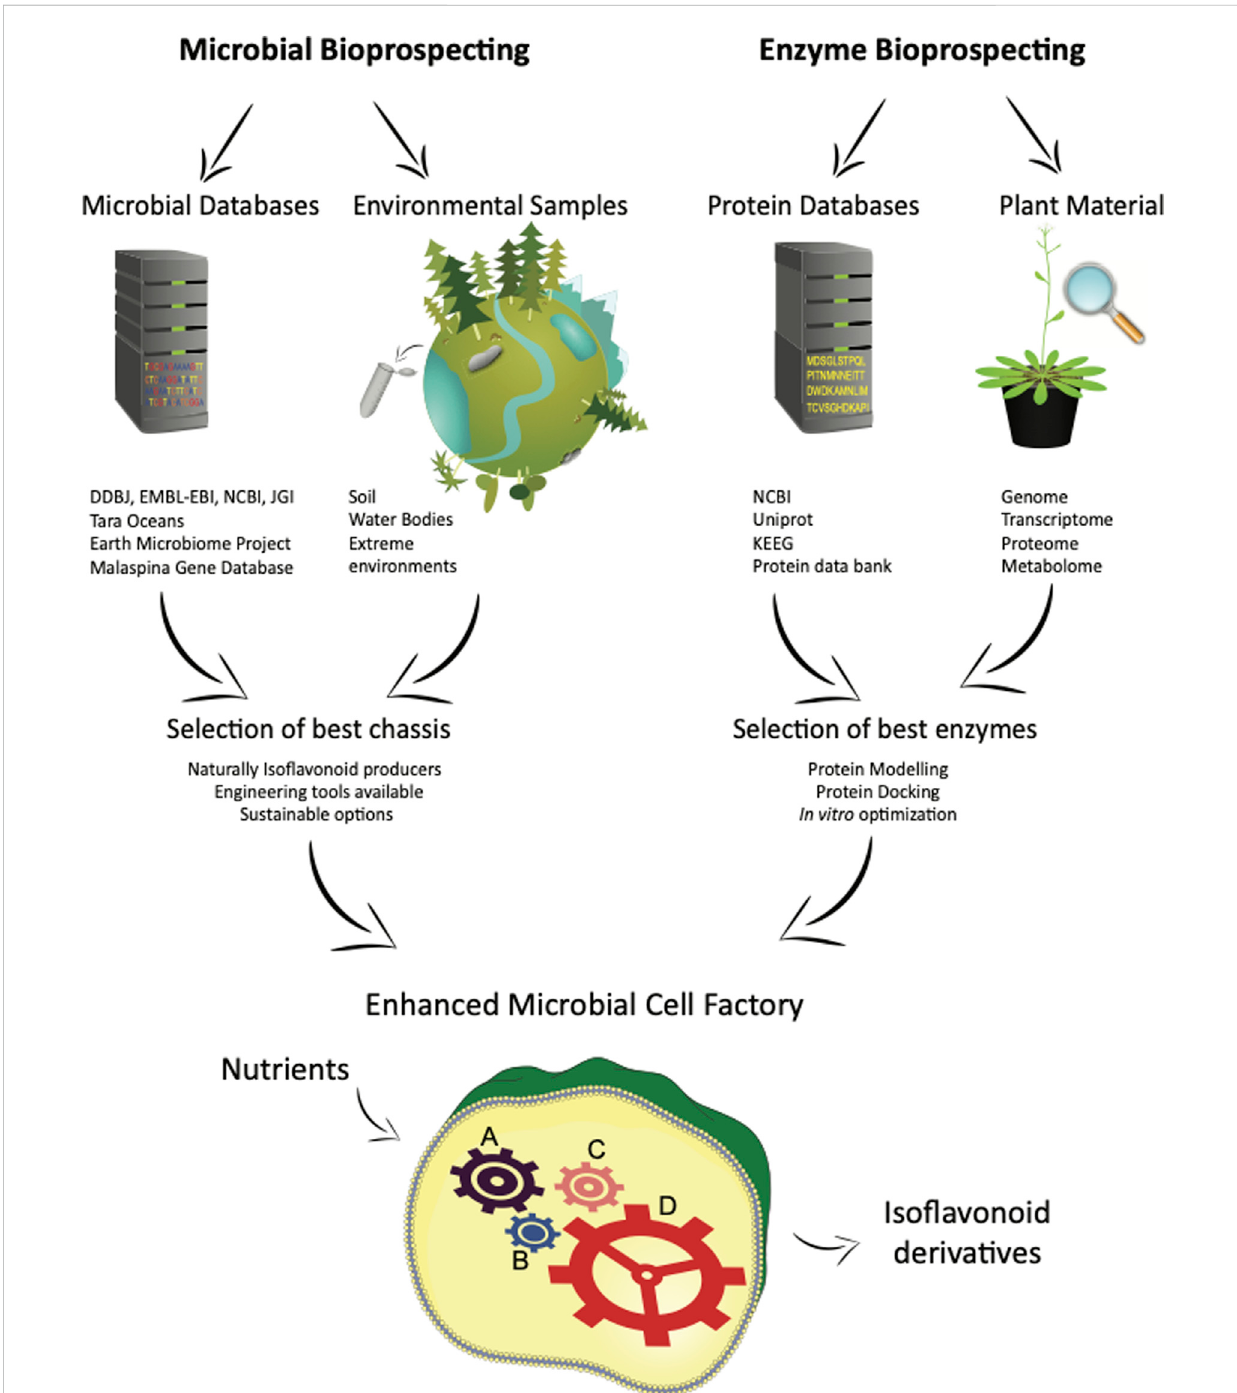
FIGURE 2 Bioprospecting strategies for microbial and enzyme bioprospecting. Microbial bioprospecting allows the identi fi cation of best chassis, whereas enzyme bioprospecting identi fi es the best enzymes for the production of iso fl avonoid derivatives using microbial cell factories.